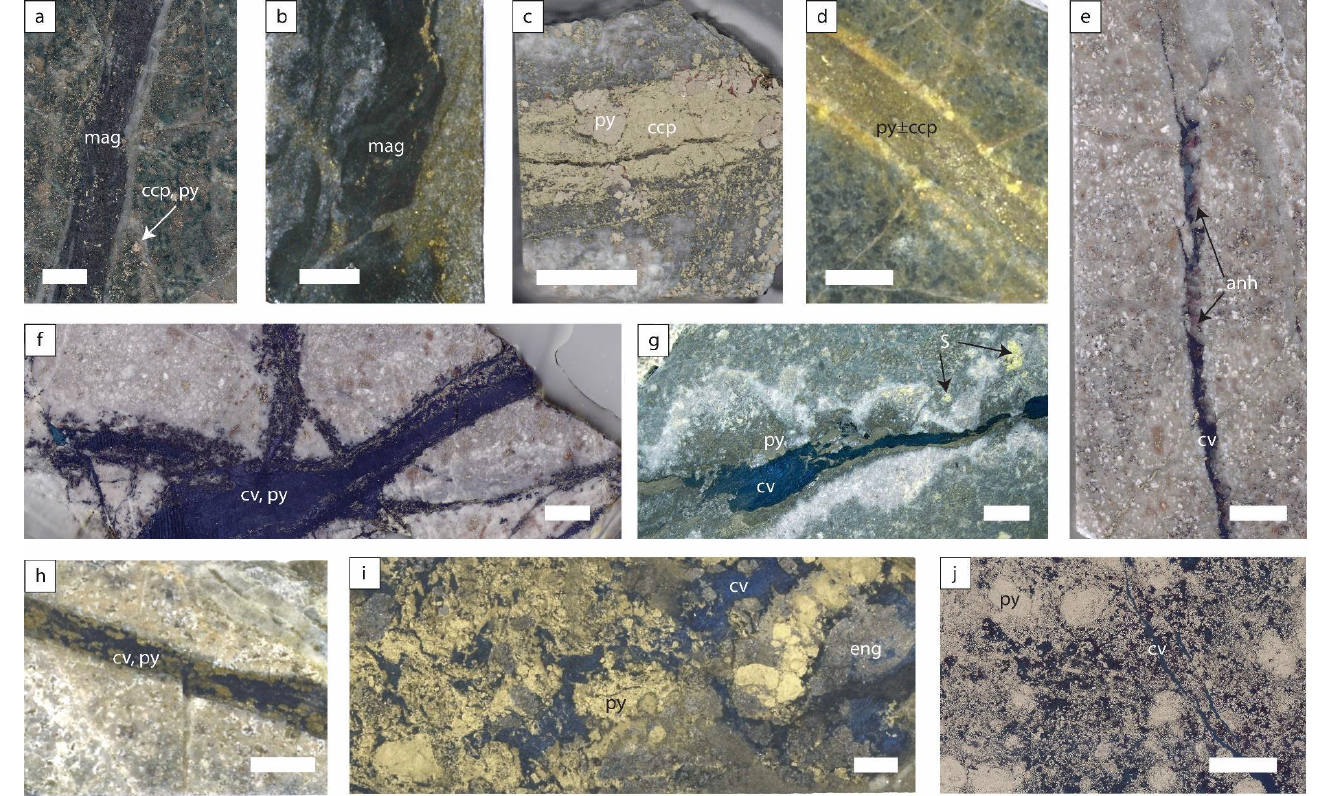
Figure 6. Mineralization styles at Bor and Cukaru Peki. ( a ) Quartz-magnetite-pyrite veins, wallrock with chlorite-sericite alteration, from deep Borska Reka porphyry zone; BGM7-316; ( b ) Magnetite- quartz veins from Cukaru Peki, deformed and cross-cut by pyrite veins; ( c ) Pyrite-chalcopyrite veins with minor quartz from below the T1 massive sulfide orebody, level of -245 m; ( d ) Pyrite-chalcopyrite veins with prominent sericite halo from Cukaru Peki; ( e ) Anhydrite-covellite vein in a wallrock with kaolinite-sericite alteration, transitional zone between Borska Reka porphyry and Tilva Ros epithermal zone; BGM1-195; ( f ) Covellite-pyrite veins crosscutting quartz-pyrite vein from the vicinity of the Tilva Ros orebody, level of -70 m; ( g , h ) Pyrite-covellite vein with solid sulfur and a prominent anhydrite-kaolinite halo from Cukaru Peki; ( i ) Massive sulfide from Cukaru Peki, with enargite overgrown by pyrite and covellite; ( j ) Massive sulfide from the central part of the T orebody, dominantly covellite and pyrite, residual quartz, BB3-23. Scale bar = 1 cm.